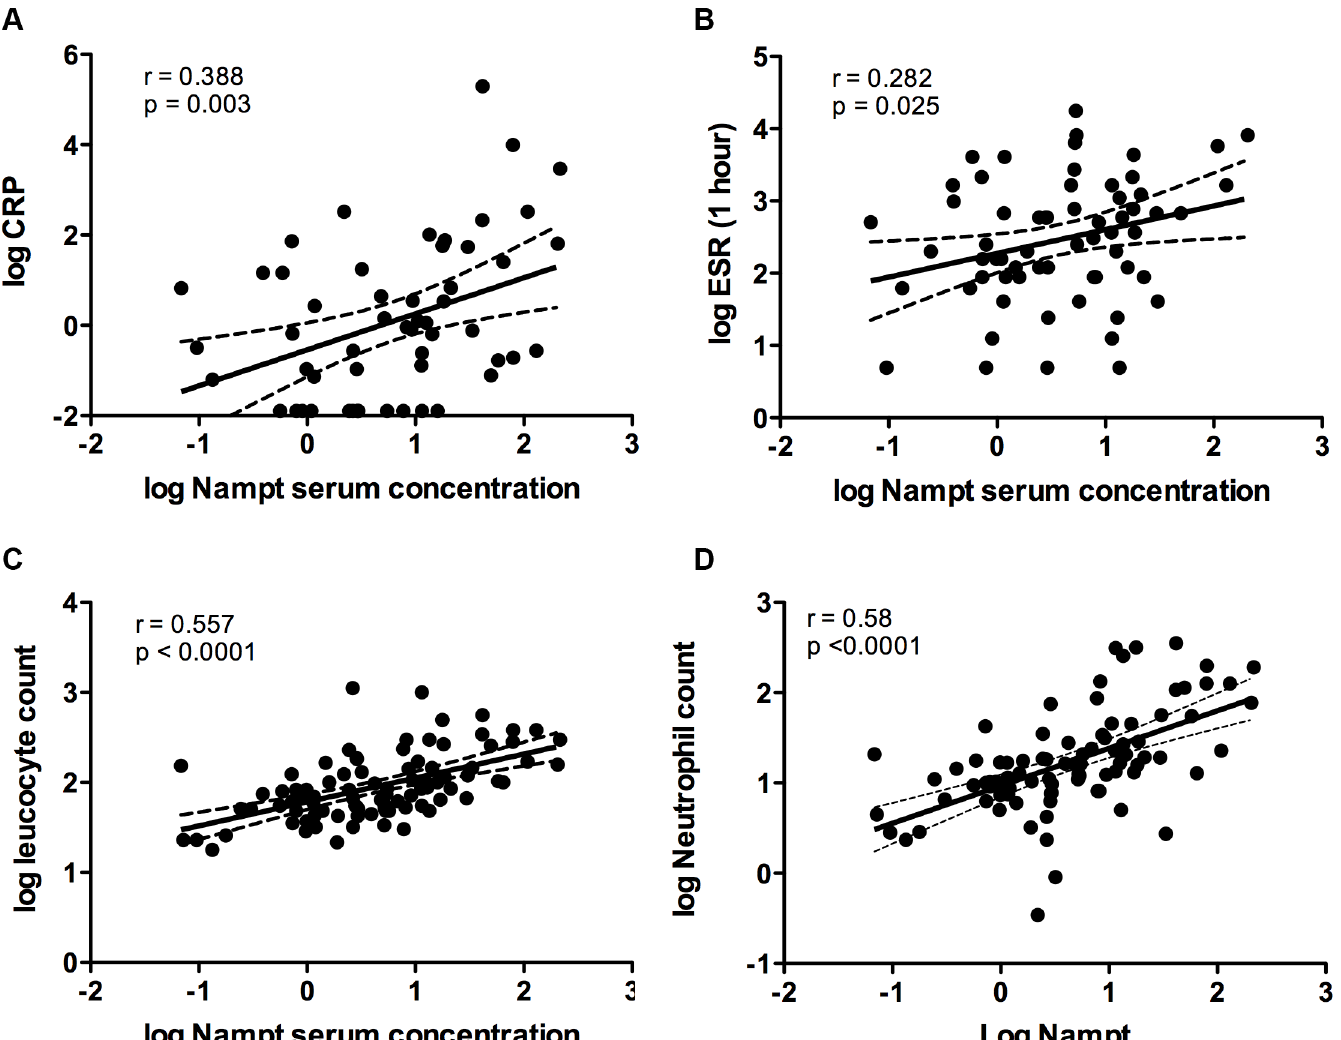
Fig 2. Positive correlation between NAMPT serum levels and inflammatory markers. Correlationbetweenlog NAMPT serum concentration and log C-reactiveprotein (A), log ESR (1 hour) (B), log leucocyte count(C) and log neutrophil granulocytecount (D).